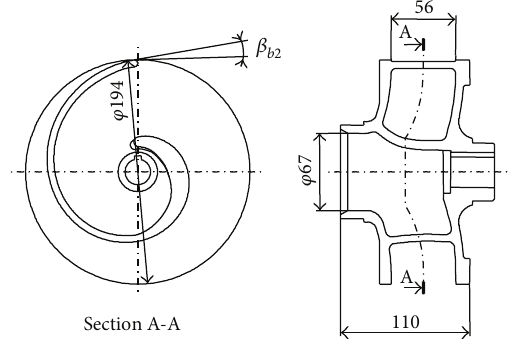
Figure 1: Test impeller.